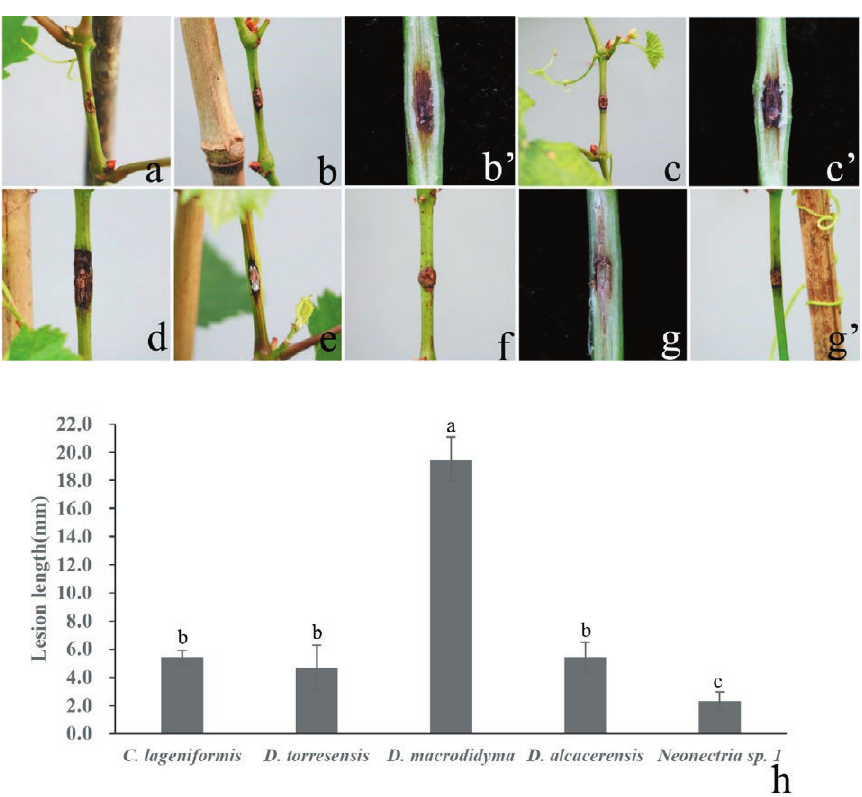
Figure 6. Pathogenicity tests results (after 80 d) of BF fungal agents inoculated onto 3-month-old ‘Summer Black’ grapevine plants in green- house. Control ( a ), Cylindrocladiella lageniformis ( b and b’ ), Dactinonectria torresensis ( c and c’ ), D. macrodidyma ( d and e ), D. alcacerensis ( f and g ), Neonectria sp. 1 ( g’ ). Histogram ( h ) of mean lesion lengths caused by inoculations with the different fungi. Means accompanied by different letters are significantly different ( P =